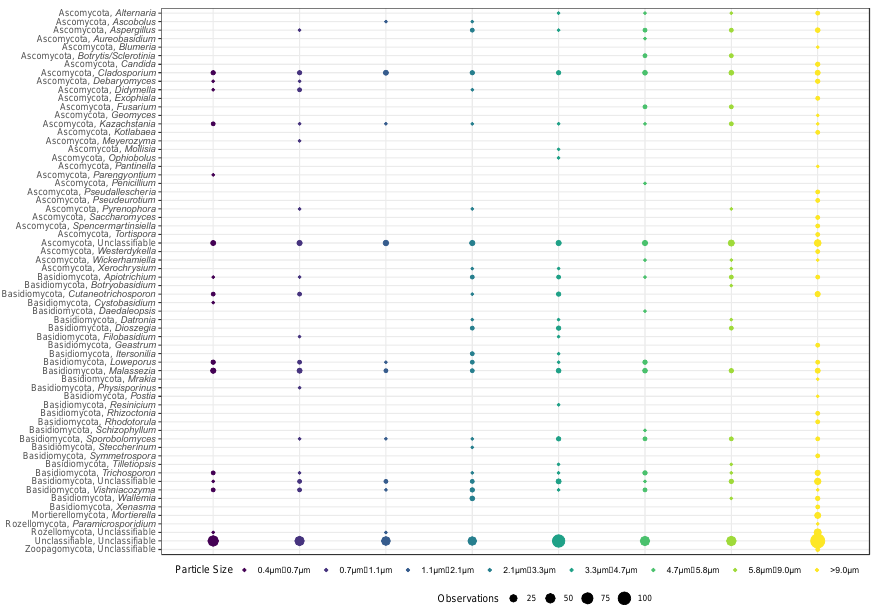
Figure 3. Bubble plot showing the total microbial diversity of presence/absence data amongst the eight stages of the ACI-8 ( x -axis) during the four sampling days. The size of each circle represents the sum of the total number of observations of that genus/phylum amongst the four sampling days. The larger the circle, the more often that genus was observed in that size fraction. Samples that have and have not been treated with PMA are represented in this graph.